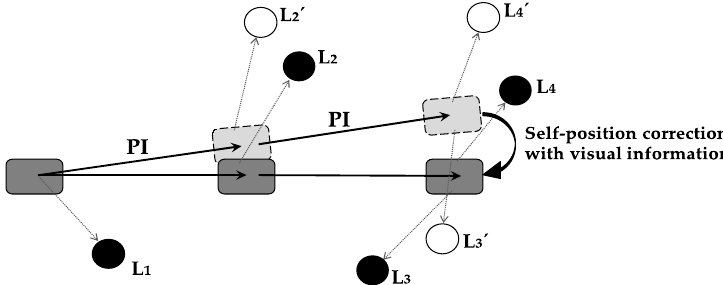
Figure 3. Self-position correction with visual information. PI: Path integration; Ln (black circle): Actual object position; L’n (white circle): Imaginary object position that should be visible from current position obtained by path integration. Dark-gray rectangle represents moving animal and actual position to which the animal is moving. Light-gray rectangle shows animal position obtained by path integration. Calculated position deviates from actual position, since error occurs in the calculation result of animal path integration. Error is corrected using visual-landmark information. Calculation-error size by path integration is difference between white-circle position, indicating imaginary object position, and black circle, indicating actual object position. Correcting this calculation error using visual information and obtaining actual position is self-position correction with visual information in this paper.